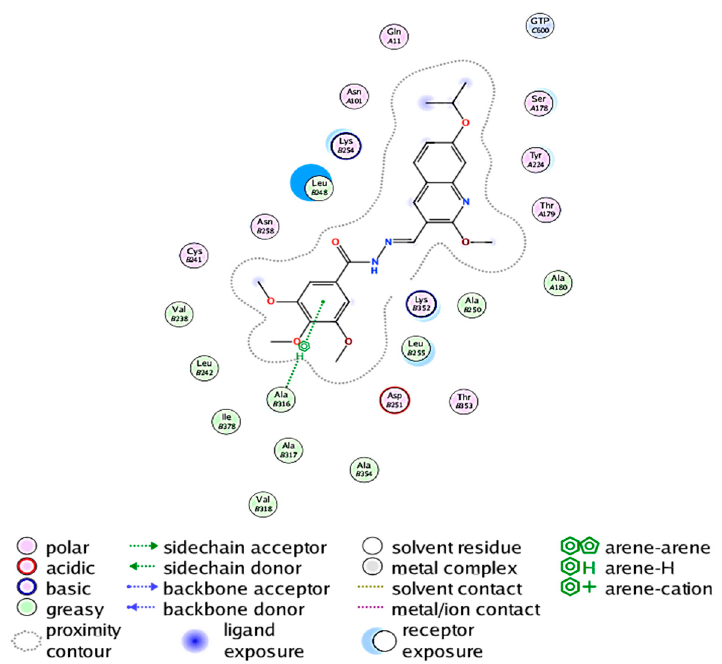
Figure 8. 2D Ligand Interaction Schematic for 19h as generated by MOE.